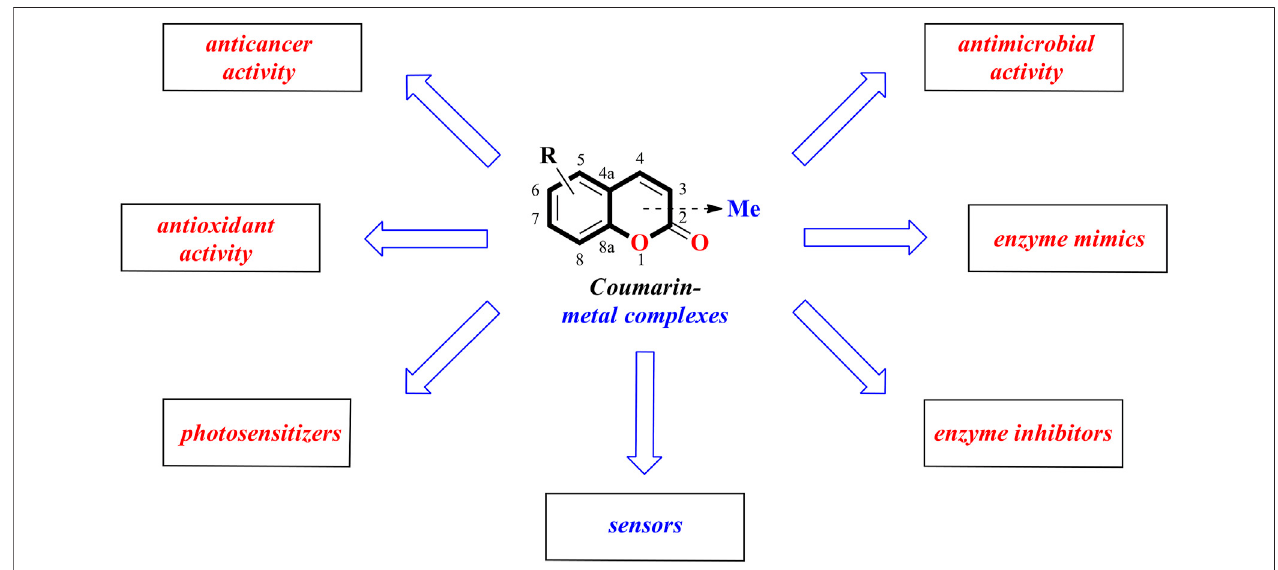
FIGURE 1 | Biological properties of coumarin-metal